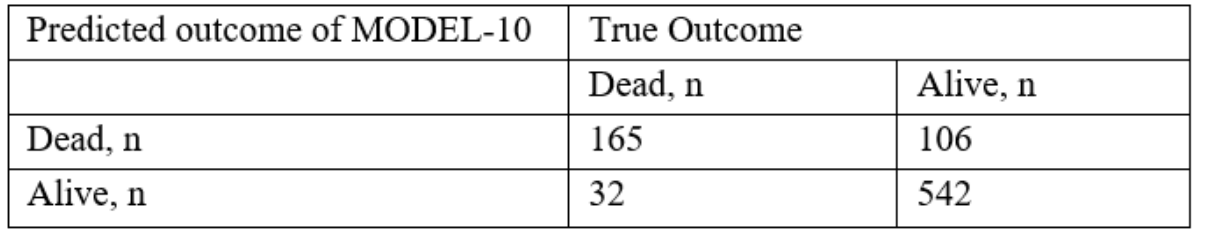
Figure 7. Binary classifier of MODEL-10. The model had an optimized F2-score threshold. This classifier had a sensitivity of 0.84, a specificity